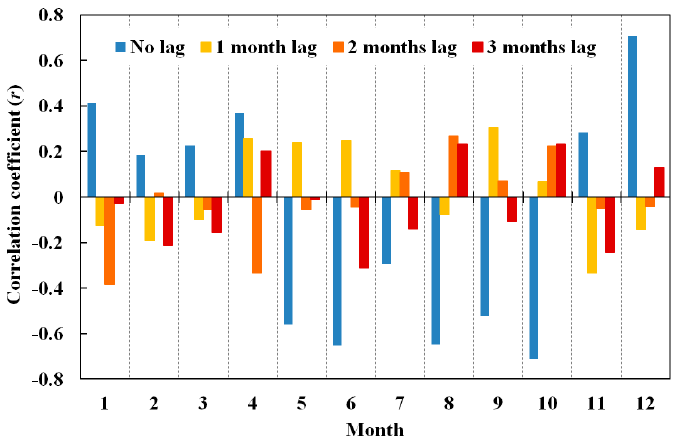
Figure 10. Lagged correlations between monthly NPP and precipitation for different months.